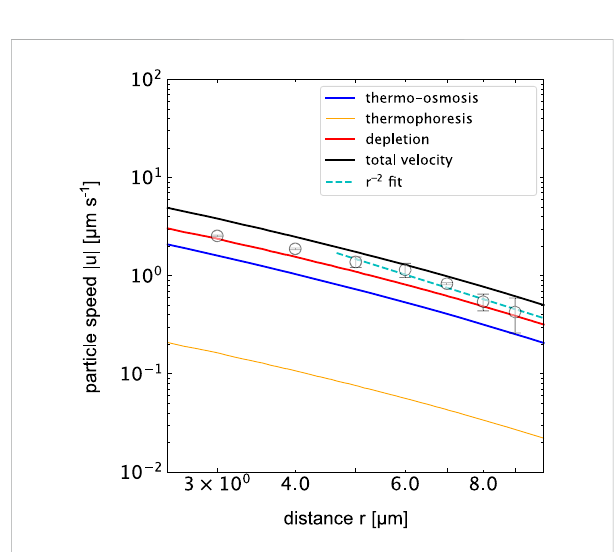
Particle speed magnitude | u | for different physical processes in the thermo fl uidic assembly of colloidal crytals when heating a gold fi lm at ( p = 0.36 mW, Δ T max = 6.6 K). The solid lines show data using thetemperaturegradient calculated in fi niteelement simulations (COMSOL).Theorangecurveindicatesthethermophoreticdriftofthe 518 nm PS colloids for D T = 0.3 μ mK − 1 s − 1 . The blue line shows the thermo-osmotic contribution calculated from the fl ow pro fi le in Figure 4C for the given Δ T max . The red line depicts the depletion induced drift according to the parameters mentioned in the text. The black line represents the sum ofall termsand the symbols indicate the experimental data. Note that thermo-osmotic, and depletion result in negative speeds and thermophoretic speeds are positive with respect to the radial